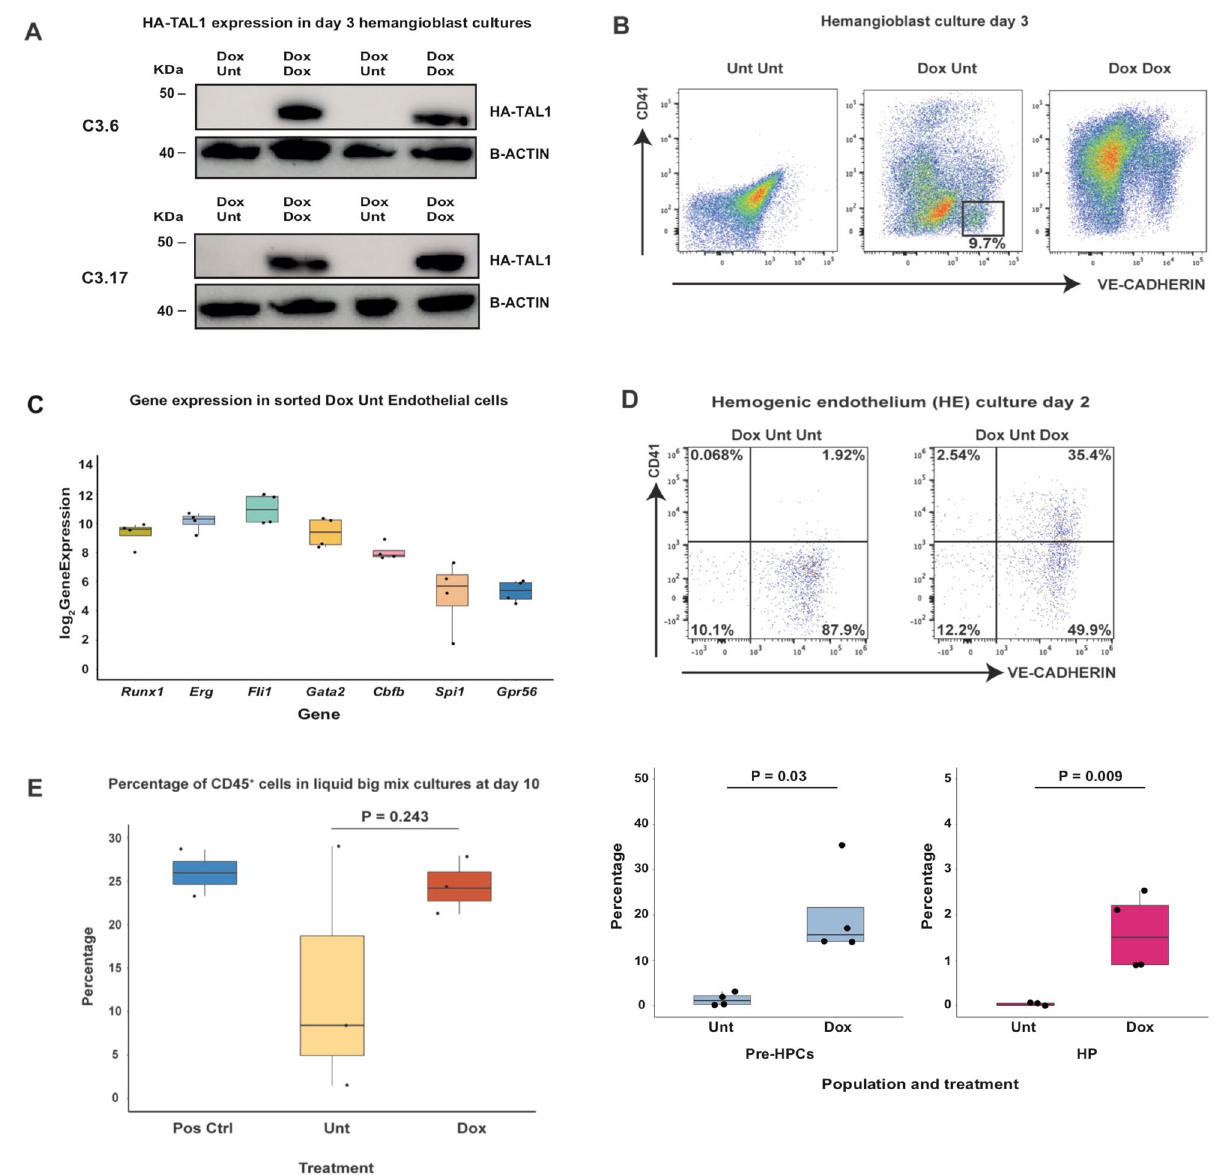
Figure 7. Rescue of Tal1 expression during hemogenic endothelium culture allows the formation of Pre-HPCs and HP from endothelium. ( A ) Western-blot (WB) analysis showing the expression of transgenic HA-TAL1 in day 3 Dox Unt and Dox Dox i3TFs Tal1 Δ/Δ hemangioblast cultures. The WB was performed on two independent repeats for each cell line. B-ACTIN was used as a loading control. ( B ) Representative flow cytometry analysis of i3TFs Tal1 Δ/Δ Unt Unt, Dox Unt and Dox Dox hemangioblast cultures at day 3. The square highlights the endothelial cell population (VE-CAD + CD41 − ) sorted from the Dox Unt condition for subsequent hemogenic endothelium culture and RNA-seq. ( C ) RNA-seq (n = 4) analysis showing the expression of the indicated genes in the FACS sorted endothelial cell population. ( D ) Results of hemogenic endothelium cultures. Top: panels showing one representative flow cytometry analysis. Bottom: box plots summarizing four independent experiments. Significance was determined by Analysis of Variance (ANOVA) test. Error bars correspond to standard deviations. ( E ) Box plots summarizing the expression of CD45 in untreated and dox-treated HE cultures subjected to a liquid hematopoietic cell growth assay in the absence of doxycycline for 10 days. Whole i3TFs Tal1 Δ/Δ Dox Dox hemangioblast cultures were used as a positive control. Significance was determined by Analysis of Variance (ANOVA) test. Error bars correspond to standard deviations. Unt Unt = untreated; Dox Unt = doxycycline added at EB day 2; Dox Dox = doxycycline added at EB day 2 and at day 0 of hemangioblast culture; CD45 = pan-hematopoietic